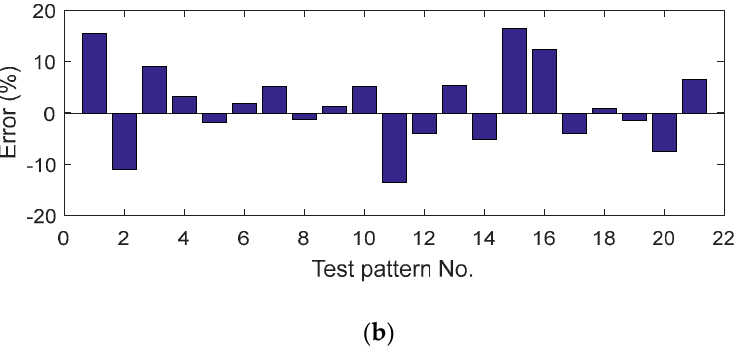
Figure 16. Estimated second stiffness results: ( a ) comparison of second stiffness; ( b ) error.